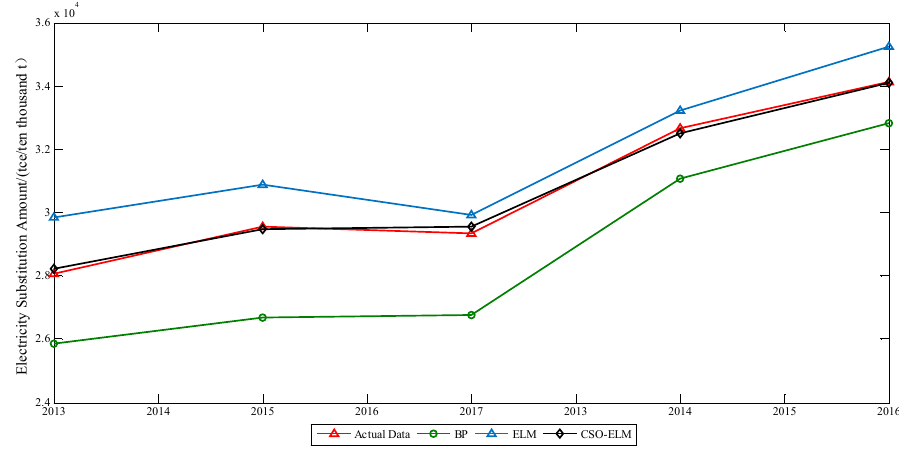
Figure 3. Results of three forecasting models.